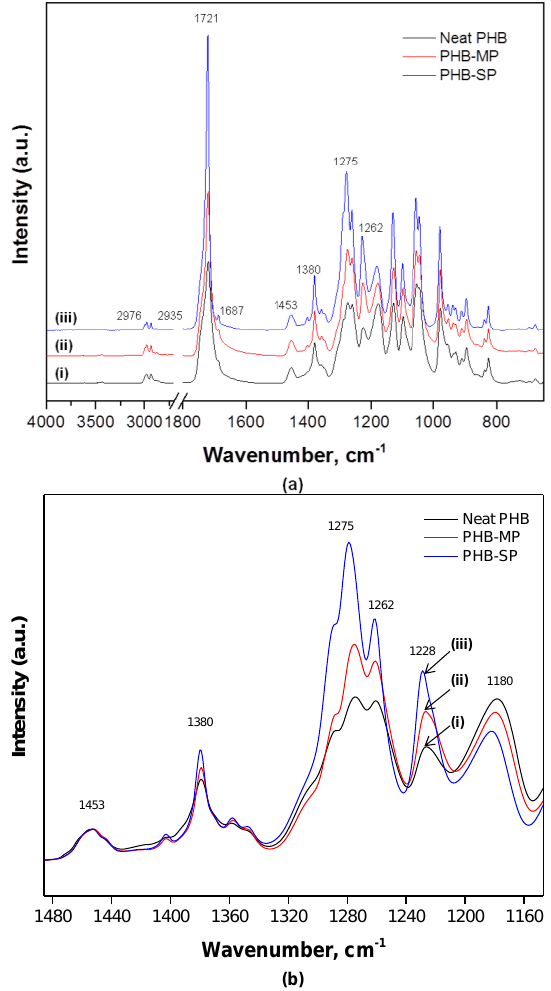
Figure 4. Fourier-transform infrared (FTIR) spectra showing ( a ) complete wavenumber range 4000–400 cm −1 ; ( b ) detailed spectra in wavenumber range 1500–1100 cm −1 for (i) neat PHB, (ii) PHB-MP and (iii) PHB-SP.